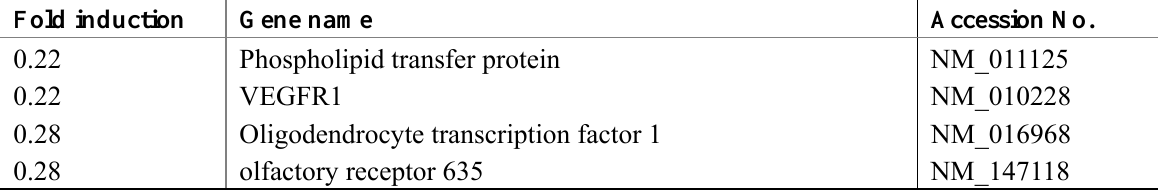
Table 2. Top 20 down-regulated genes in the VASH1 stable